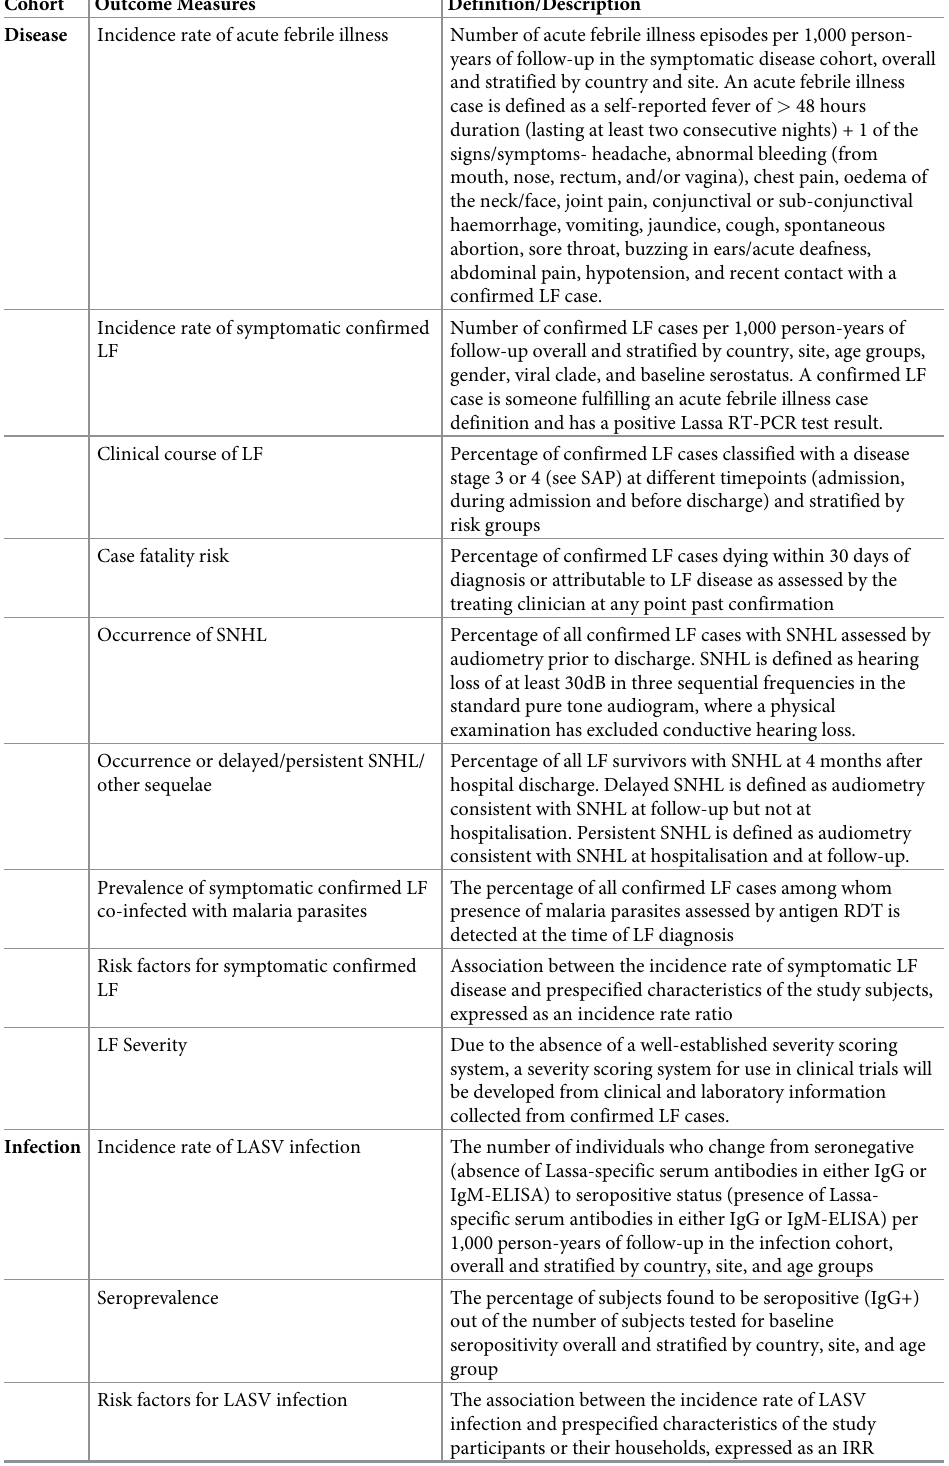
Table 2. Outcome measures of the Enable Lassa research